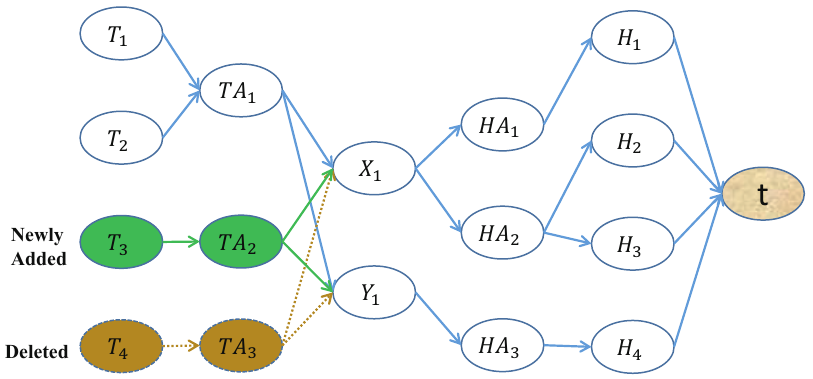
Figure 3. Influences of changing tasks on the network